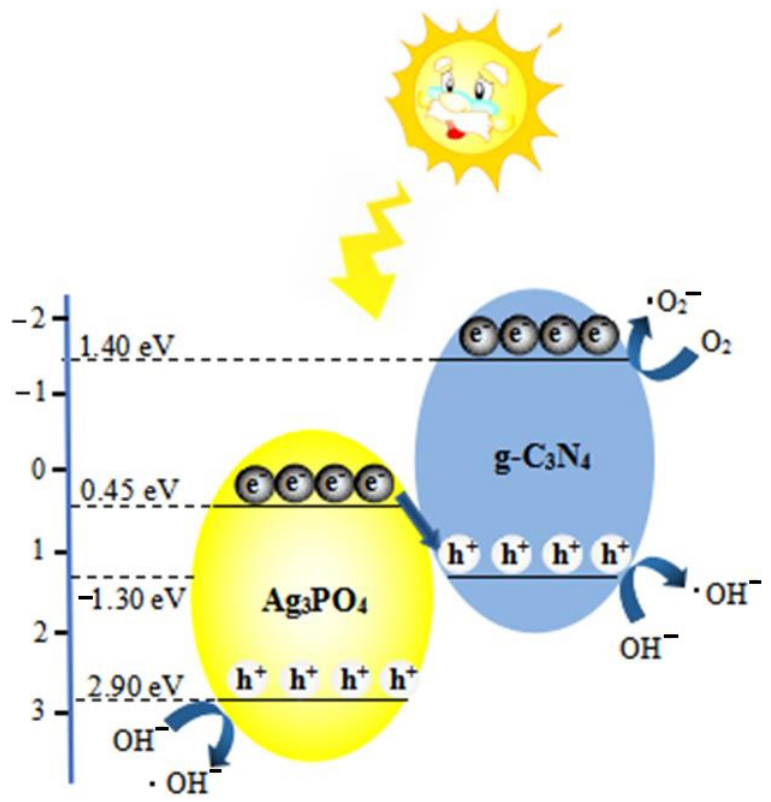
Figure 8. Energy band structure and Z-scheme photocatalytic mechanism of Ag 3 PO 4 /g-C 3 N 4.